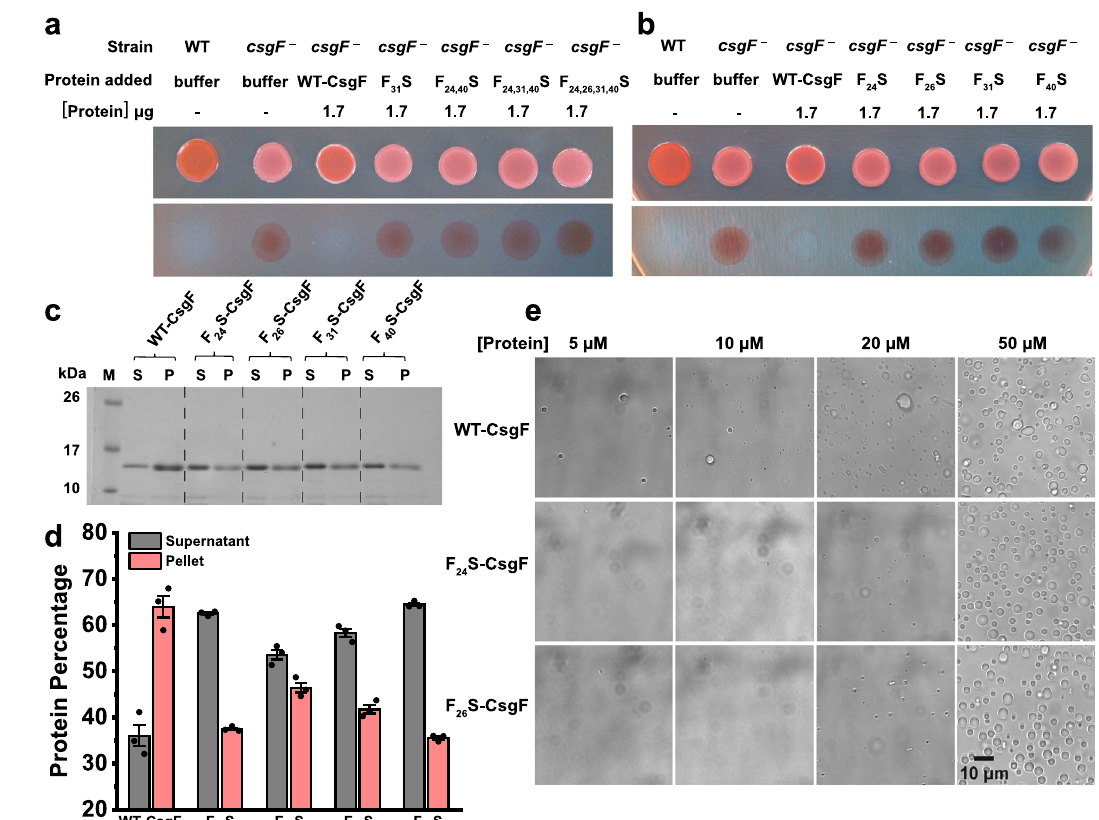
Fig. 4 | Single phenylalanine mutation impairs curli assembly and CsgF phase separation. a , b Exogenous complementation of csgF ‒ cells with phenylalanine mutants. c Coomassie-stained SDS-PAGE on the supernatant and pellet samples of singlephenylalaninemutantsaftersedimentation.M:Molecularweightmarkers,S: